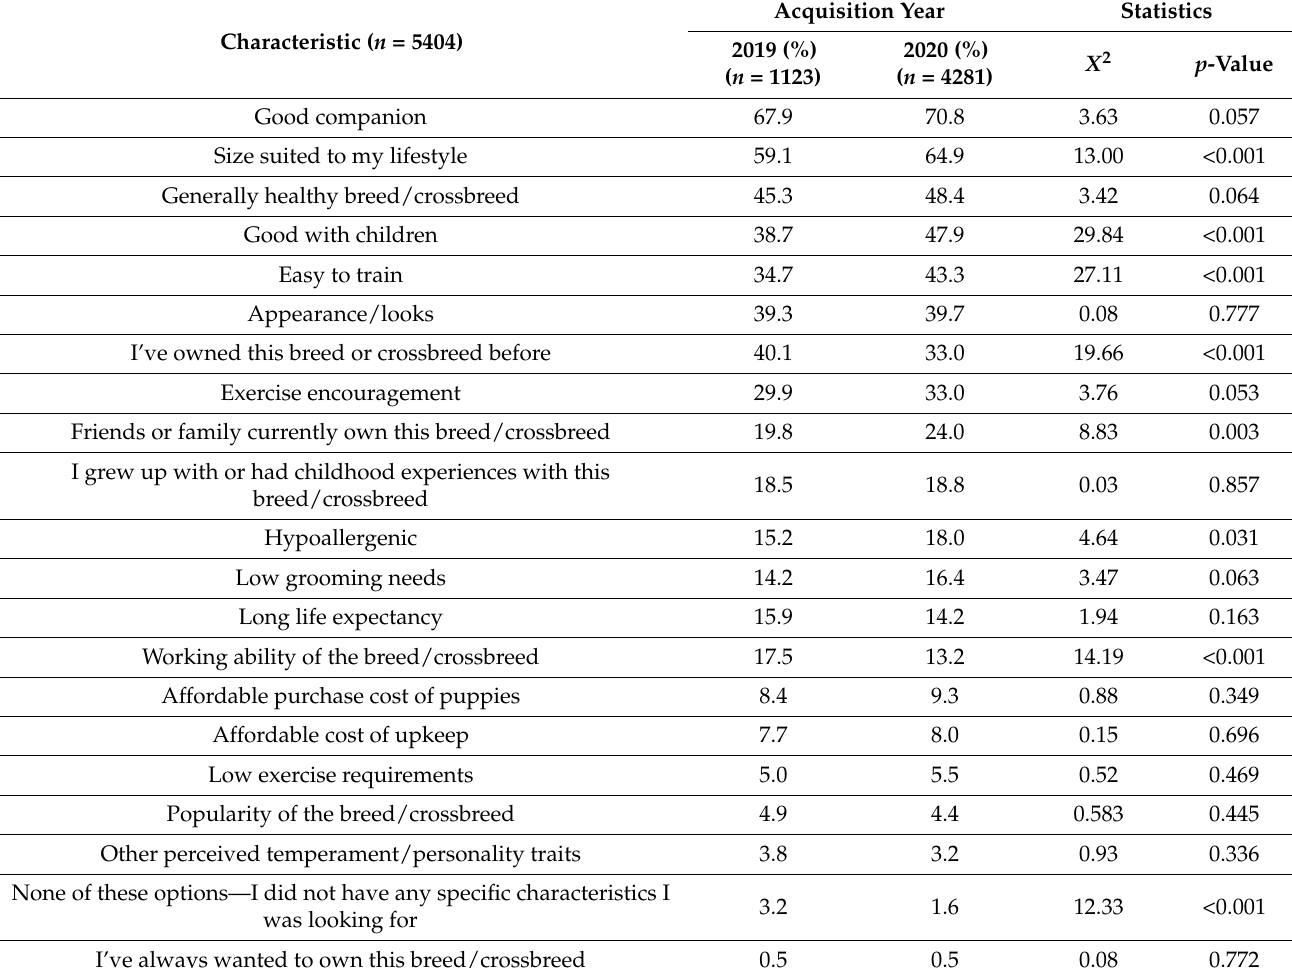
Table 3. Characteristics sought by owners when selecting a particular breed/crossbreed puppy to purchase, with compar- isons between 2019 puppy ( n = 1123) and Pandemic Puppy owners ( n = 4281) in the